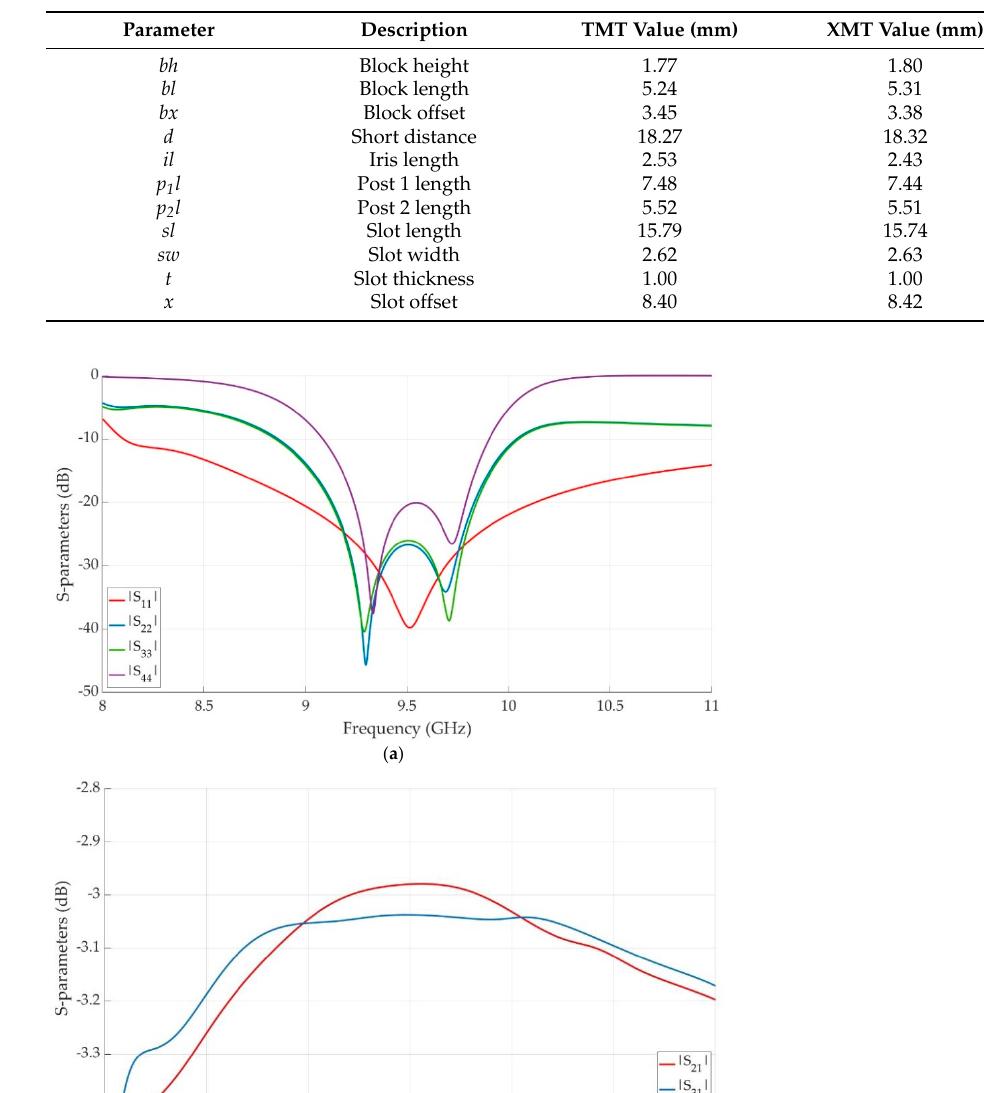
Table 4. Magic-T geometrical parameters.